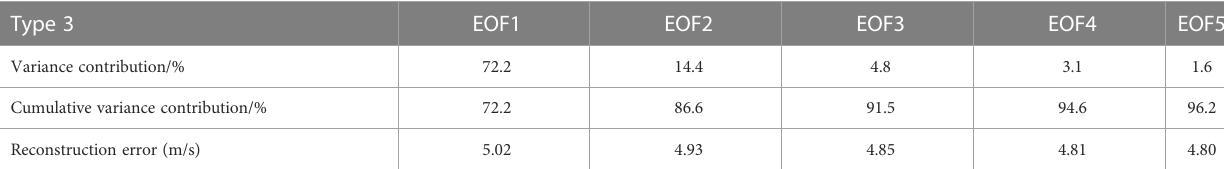
TABLE 4 First fi ve orders contribution rates and errors for Type 3.